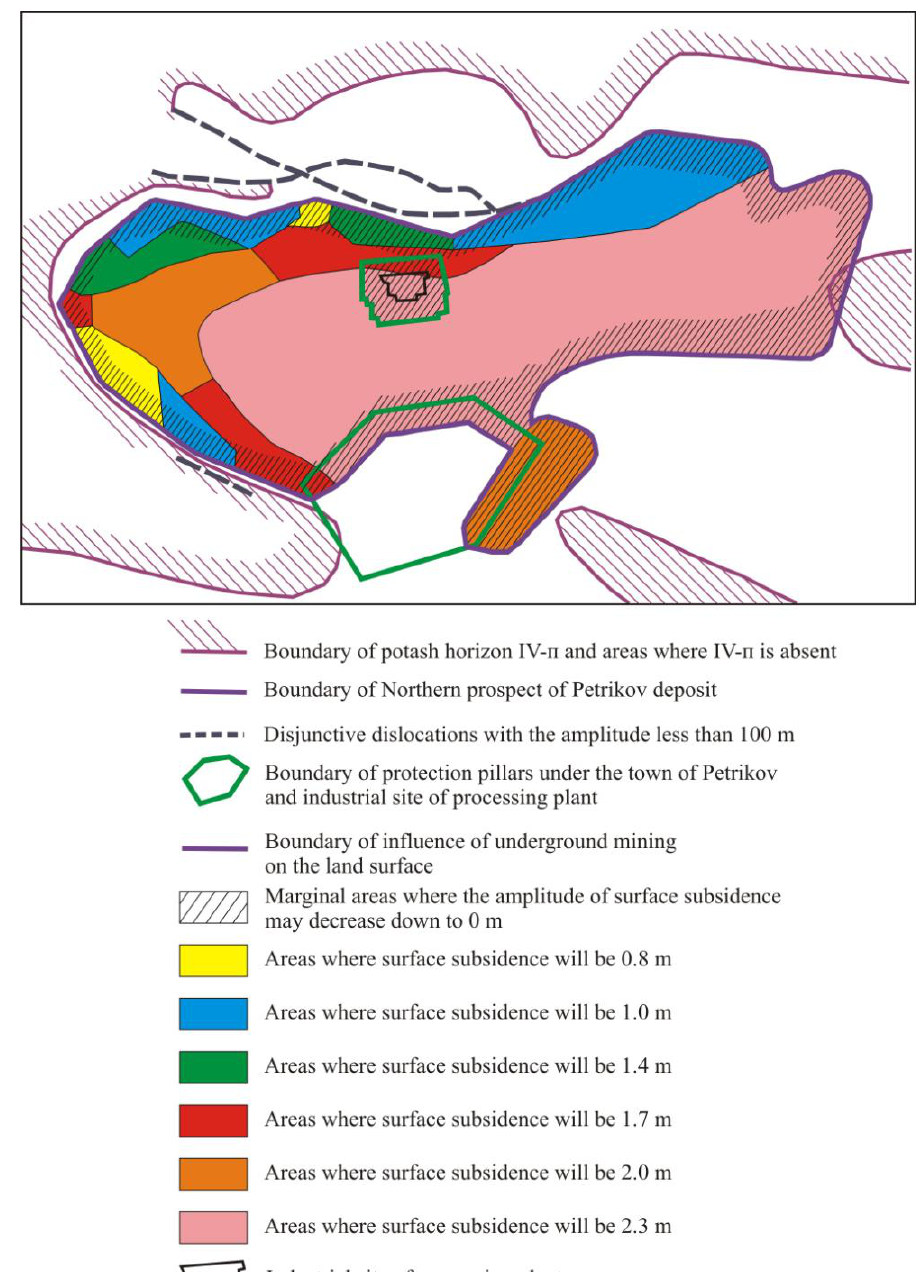
Fig. 4. Amplitude of land subsidence due to mining of potash horizon